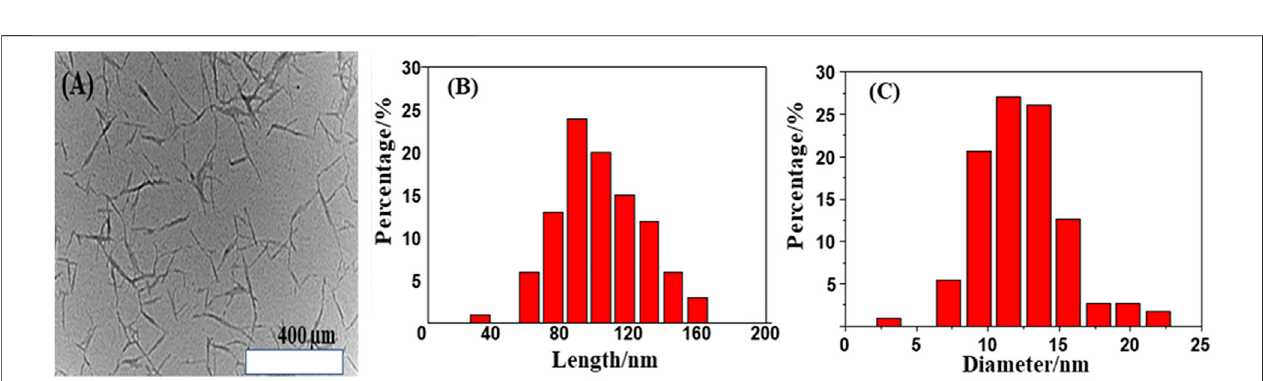
FIGURE 4 | (A) The rod-shaped morphology of CNCs observed through TEM, (B) length, and (C) diameter distribution of CNCs.